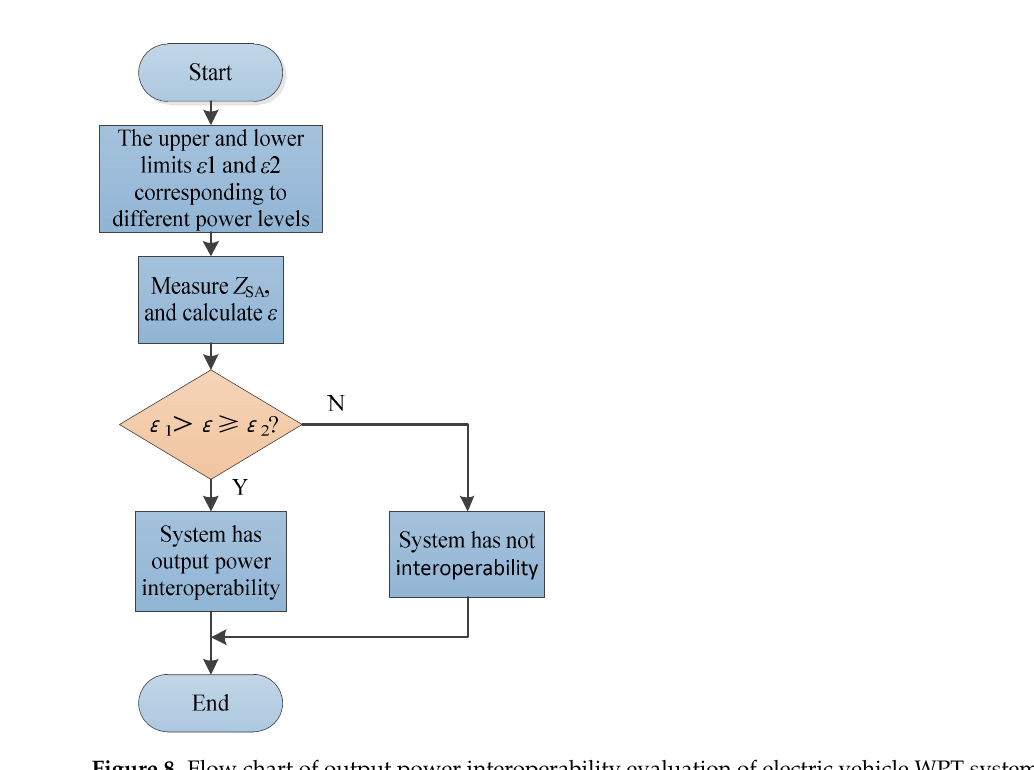
Figure 7. Flow chart of efficiency interoperability evaluation of WPT system for electric vehicles.